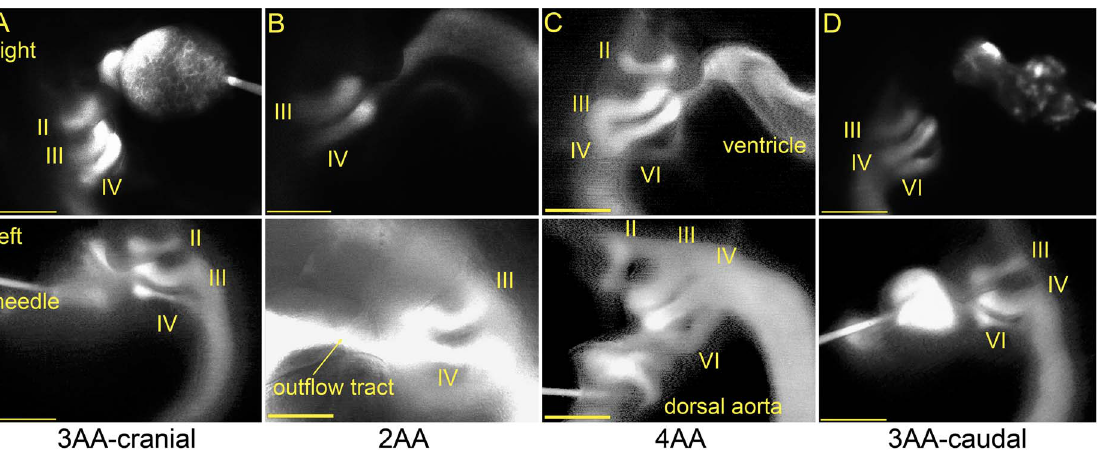
Figure 3. Four distinct AA configurations were observed at stage 21, identified through fluorescent dye microinjection. Right (top) and left (bottom) lateral snapshots from video recordings are shown. (A) The 3AA-cranial pattern includes AA II, III, and IV. (B) The 2AA pattern only includes AA III and IV. (C) AA II, III, IV, and VI are present in the 4AA configuration. (D) The 3AA-caudal pattern includes the caudal-most AA VI. All scale bars are 500 m m.